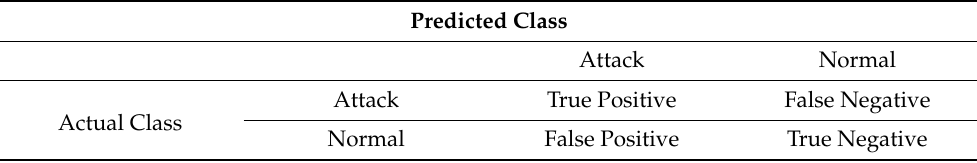
Table 3. Attributes of the confusion matrix.